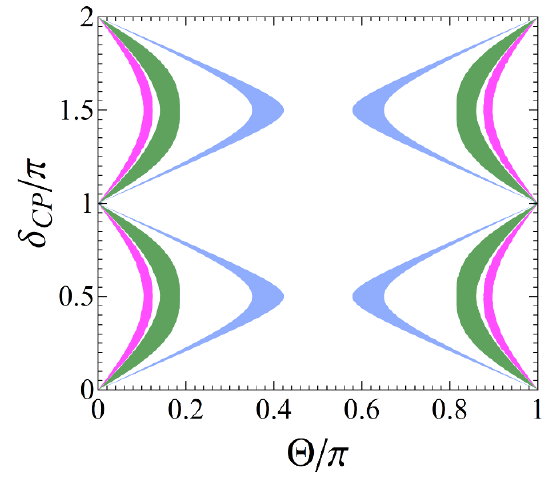
Figure 8 . Predictions for the Dirac CP violation phase (cid:14) CP as a function of the CP label (cid:2) associated with generalized CP symmetries. The light blue, magenta and green regions correspond to the cases of generalized e (cid:0) (cid:22) , e (cid:0) (cid:28) and (cid:22) (cid:0) (cid:28) symmetries,